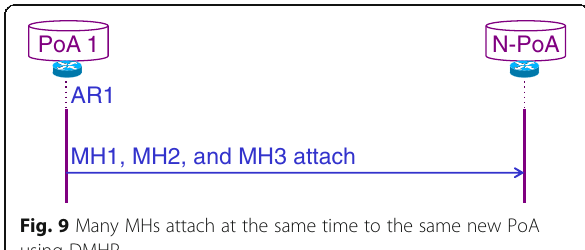
Fig. 9 Many MHs attach at the same time to the same new PoA using DMHP